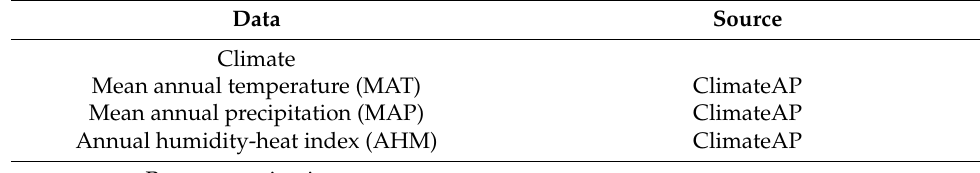
Table 1. Environmental variables used in this